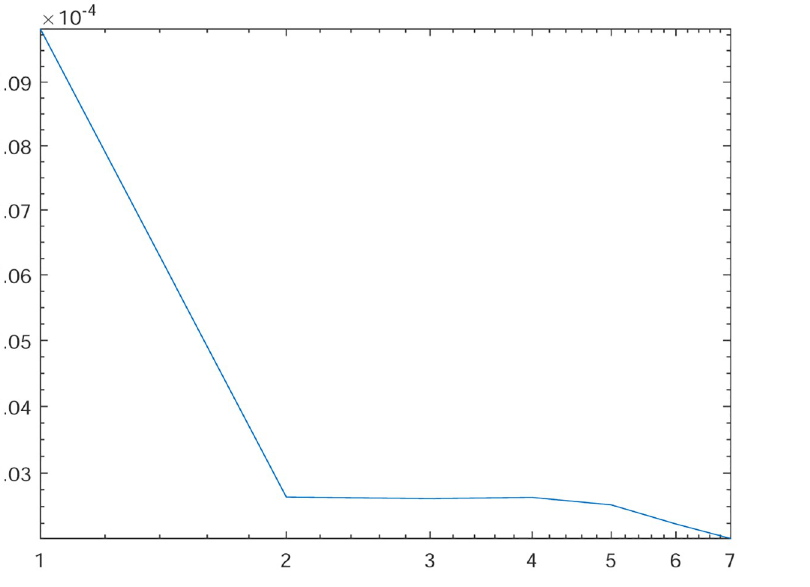
Fig 8. The behavior of the error with respect to the parameter γ for the Experiment